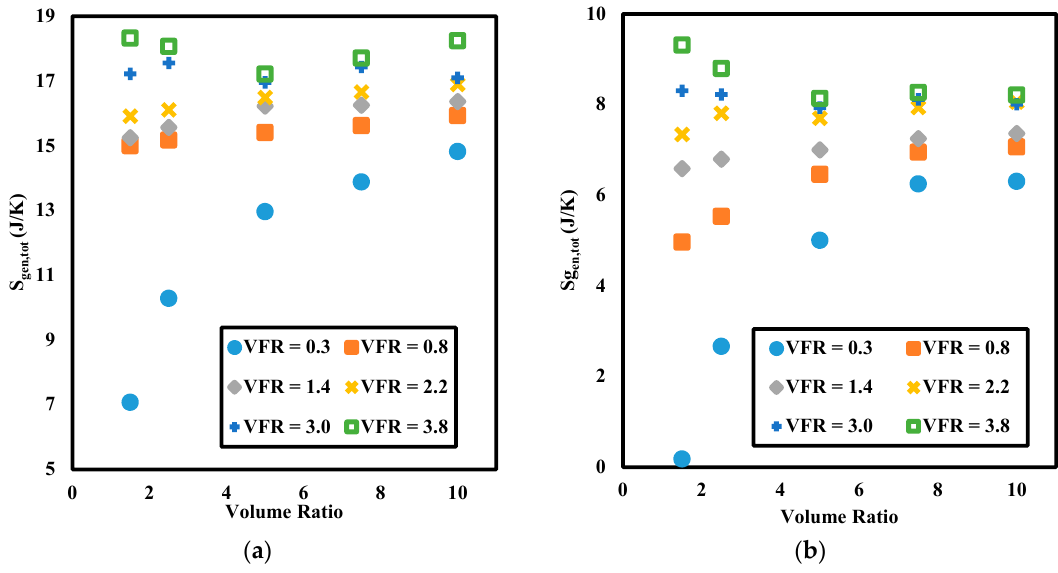
Figure 9. Entropy generation for various volume ratios (VR) and volumetric flow rates (VFR, in m 3 / hr), for initial PCM - HTF temperatures of: ( a ) 473–403 K, ( b ) 460–418 K.